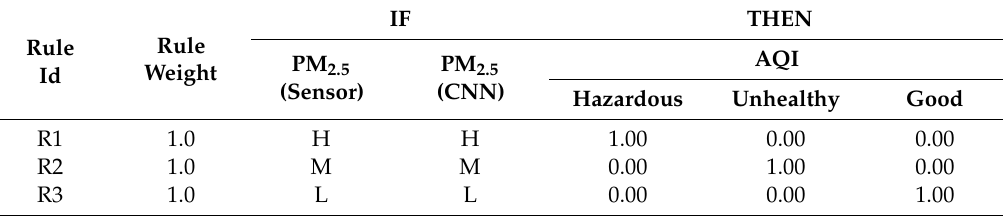
Table 4. Rule base under disjunctive